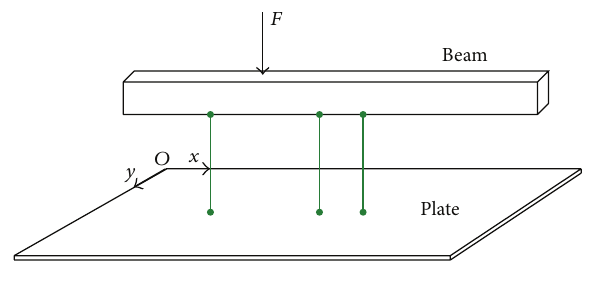
Figure 6: The beam-plate system.